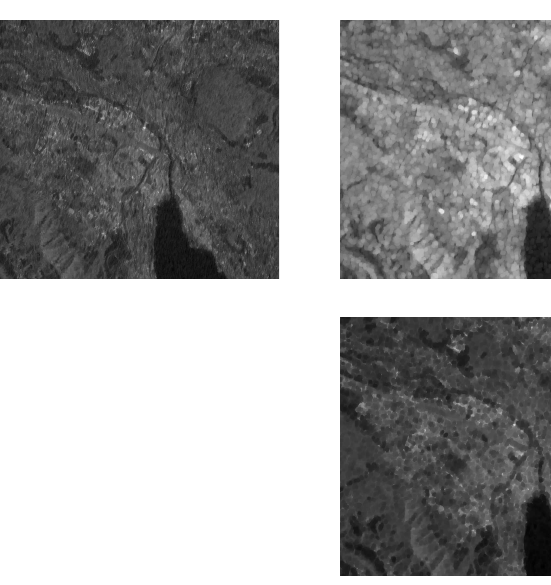
Figure 5. Morphological opening and closing operations on intensity of VH channel with a radius of 5, for the data of city Zurich. From left to right, top to bottom: VH channel in dB, opening, opening by reconstruction, closing, and closing by